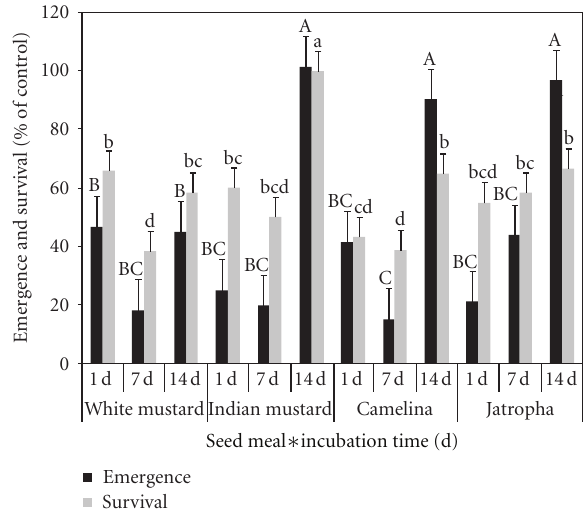
Figure 5: Interactive e ff ects of “seed meal source and incubation time” on pigweed emergence (uppercase letters) and survival (lowercase letters). Means within emergence or survival followed by the same letter are not di ff erent at P < 0 . 05 by Fisher’s protected LSD. Data are means (four replications) ± SE.